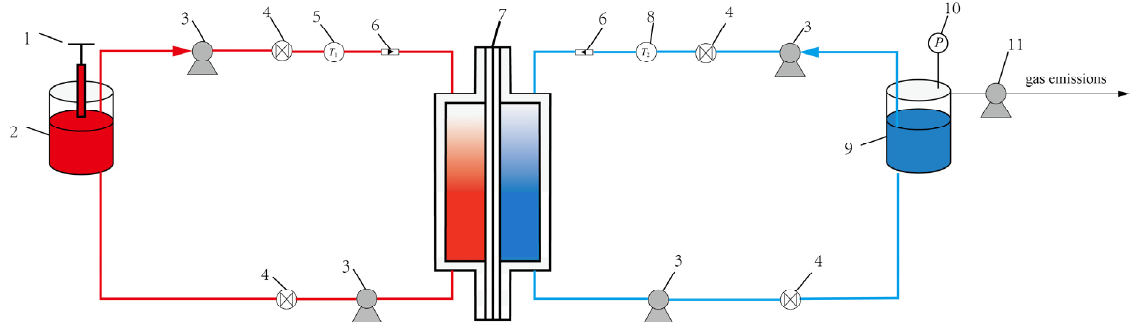
Figure 3. Schematic diagram of VEDCMD experiment. 1—Heater, 2—Seawater tank, 3—Micro- circulation pump, 4—Control valve, 5—Temperature sensor (seawater), 6—Liquid flow meter, 7—DCMD module, 8—Temperature sensor (freshwater), 9—Freshwater pressure stabilization tank, 10—Vacuum gauge, 11—Vacuum pump.